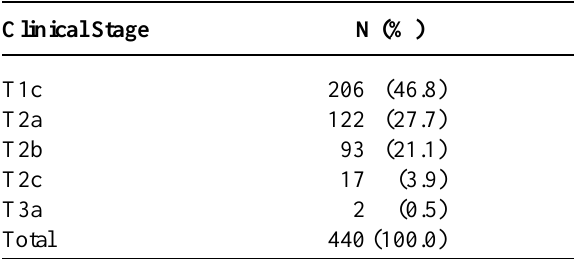
Table 1 – Patient distribution according to clinical stag- ing (AJCC,